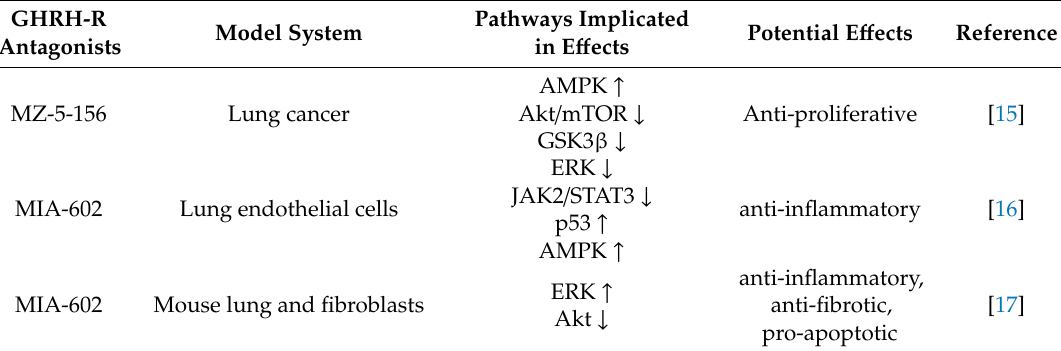
Table 1. E ff ects of GHRH-R antagonists in lung inflammation and cancer